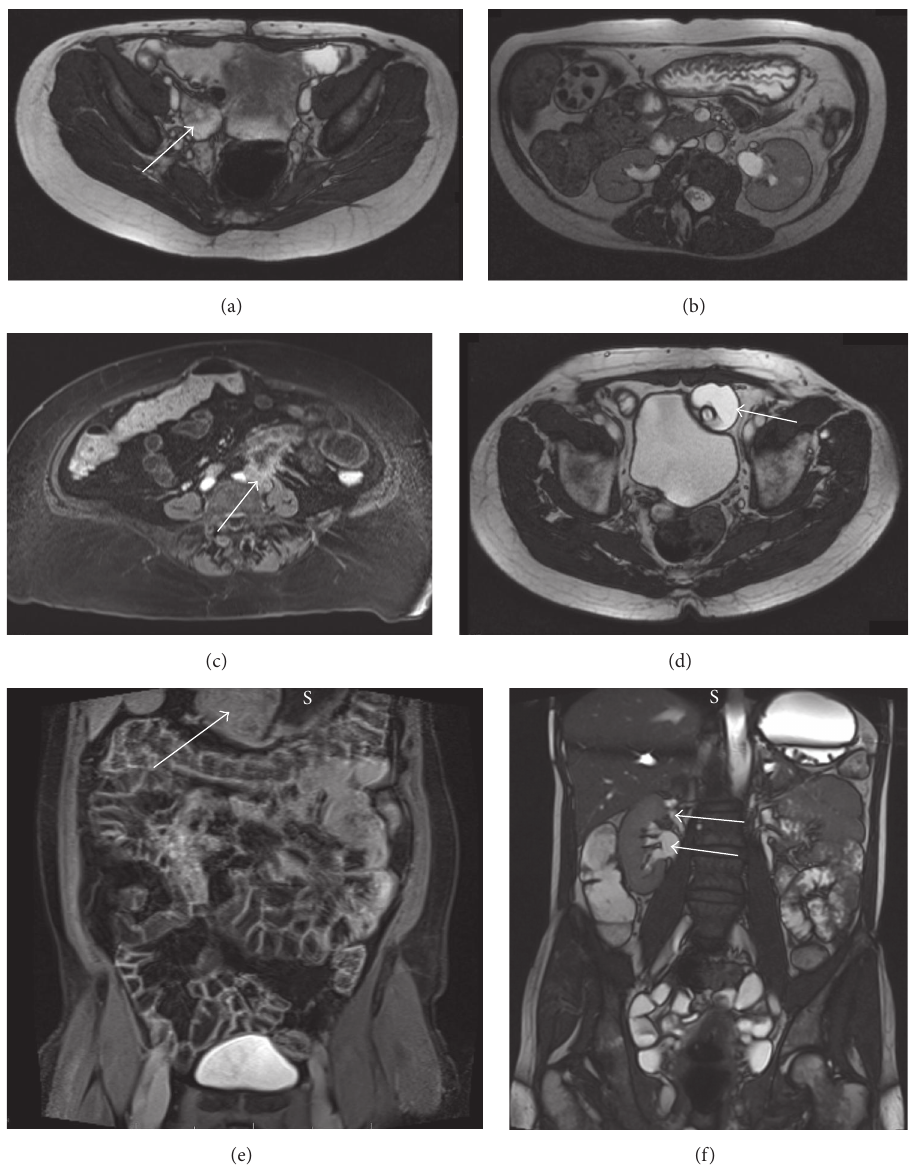
Figure 3: Extraenteric incidental findings: (a) right hydrosalpinx (arrow, axial T2); (b) gallstones in gallbladder (axial T2); (c) left ureteric tumour (arrow) with adherent jejunal loop (axial T1 postgadolinium); (d) suprapubic catheter balloon (arrow) lying outside bladder (axial T2); (e) gastric tumour (arrow; S: stomach; coronal T1 postgadolinium); (f) duplex kidney with upper and lower moieties identified (arrows, coronal